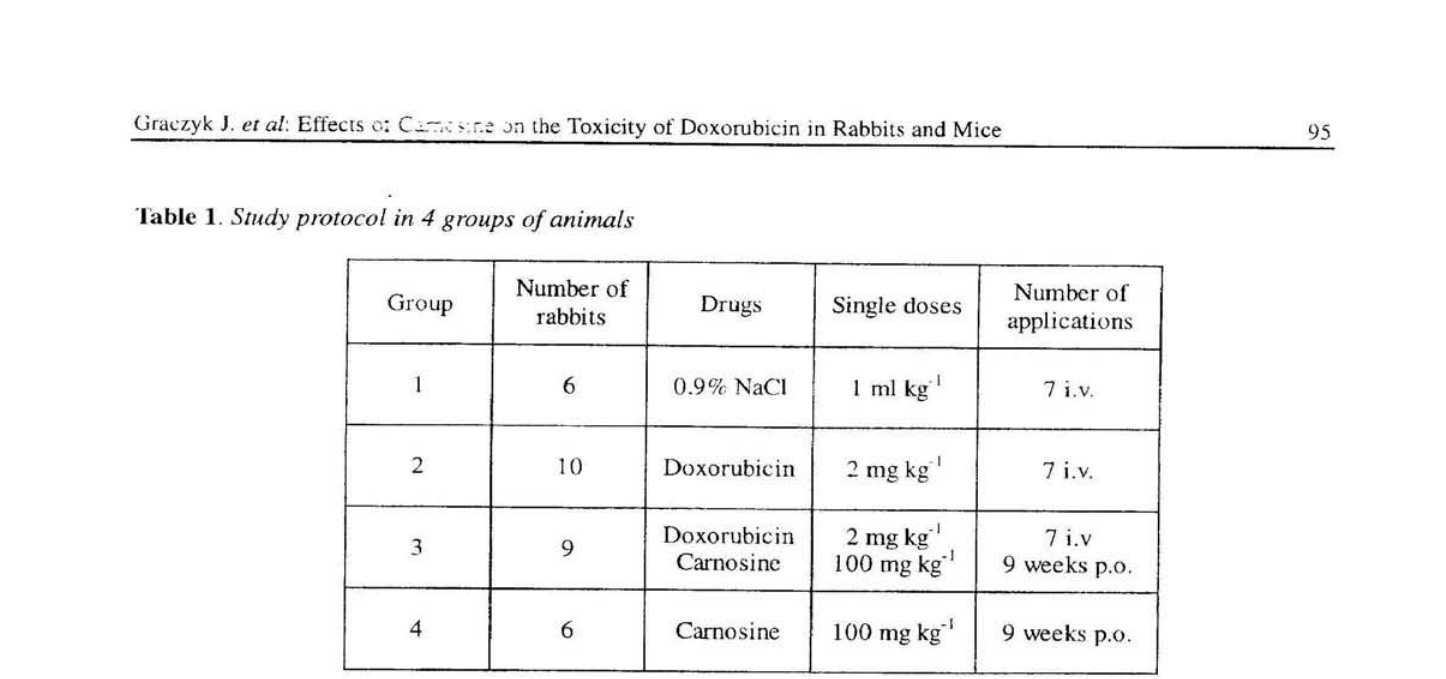
Table 1. Study protocol in 4 groups of animals